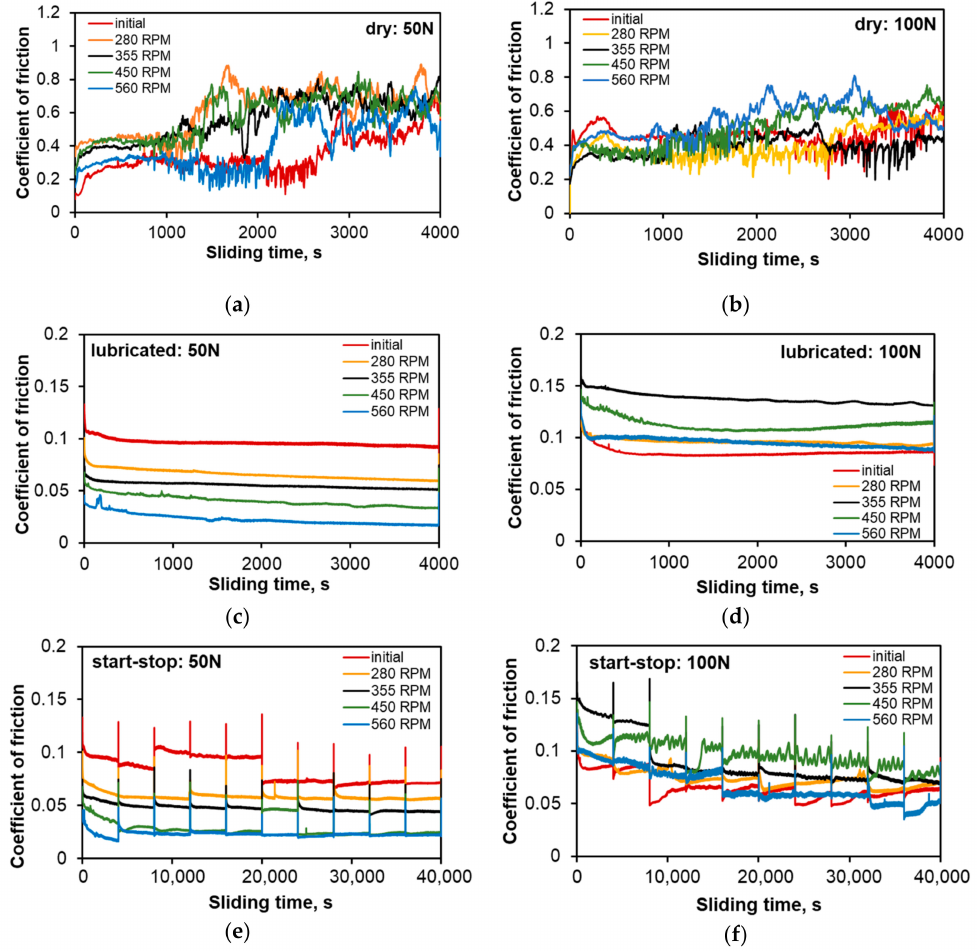
Figure 8. Coe ffi cient of friction of SnSb11Cu6 alloy before and after FSP as a function of time and process conditions; ( a ) technically dry friction, load 50 N; ( b ) technically dry friction, load 100 N; ( c ) lubricated friction, load 50 N; ( d ) lubricated friction, load 100 N; ( e ) lubricated friction—start–stop, load 50 N; ( f ) lubricated friction—start–stop, load 100